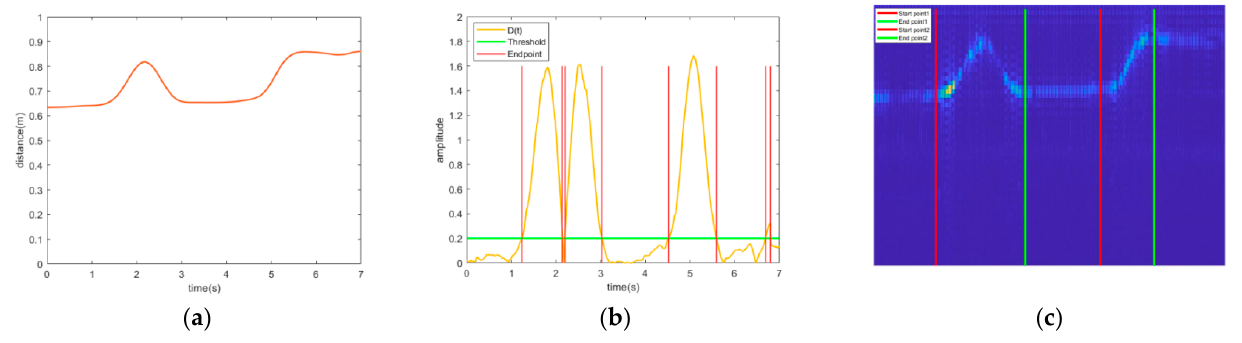
Figure 10. Gesture Segmentation: ( a ) Sample to be segmented; ( b ) All detected endpoints; ( c ) Seg- mentation result.